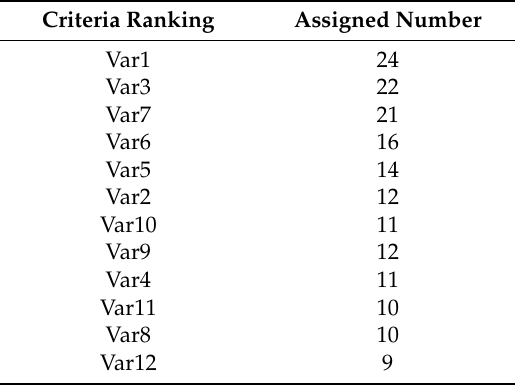
Table 5. Score indicators.